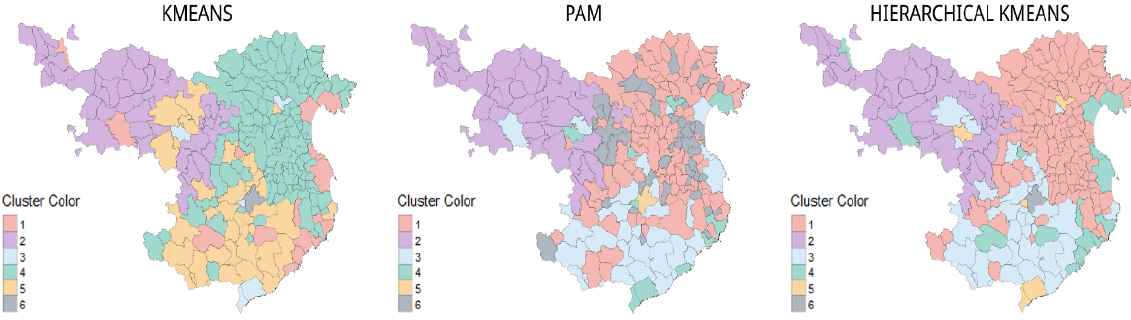
Table 4. Measurement of the number of cases that vary between clusters to study the variability of results.